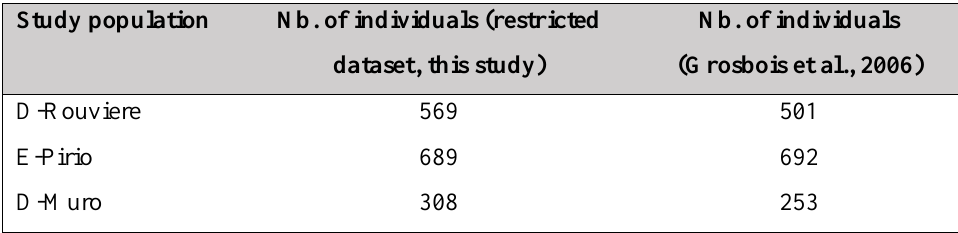
Table S3 : Sample sizes obtained with our restricted dataset and sample sizes used in Grobois et al. (2006). Study population Nb. of individuals (restricted Nb. of individuals dataset, this study) (Grosbois et al., 2006) D-Rouviere 569 501 E-Pirio 689 692 308 253